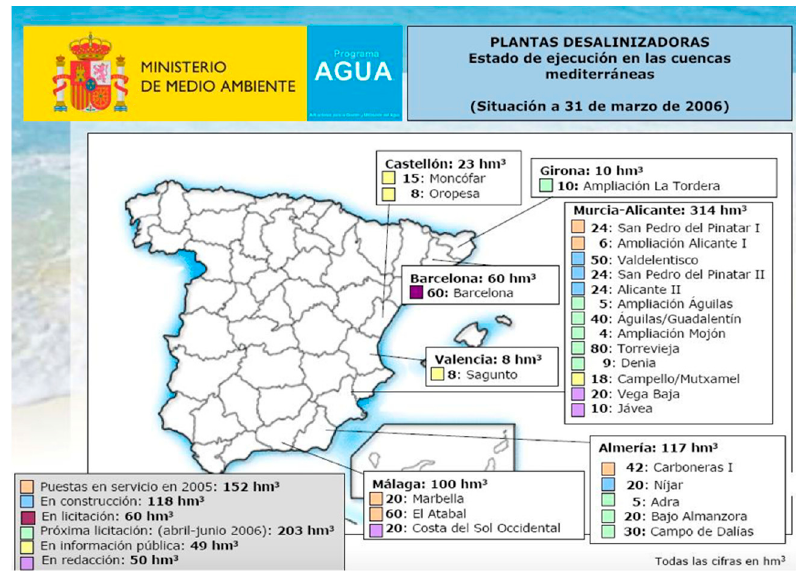
Figure 1. A.G.U.A. Programme. Source: Spanish Ministry of the Environment (currently called Ministry of Ecological Transition).